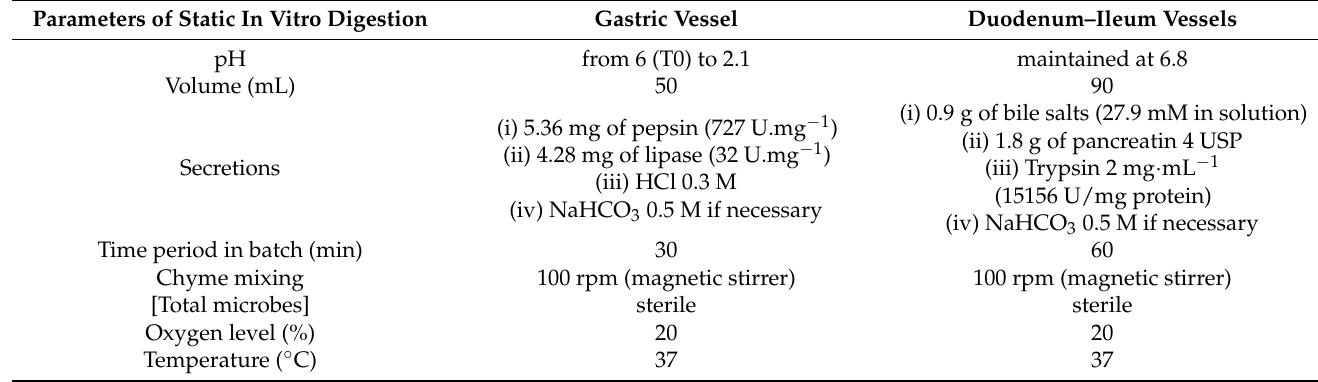
Table 3. Static in vitro gastro-ileal digestion procedure. A static batch incubation (Erlenmeyer) was used to reproduce the physicochemical parameters of gastro-ileal digestion. Digestive secretions and solutions for pH adjustment were manually added during the 90 min